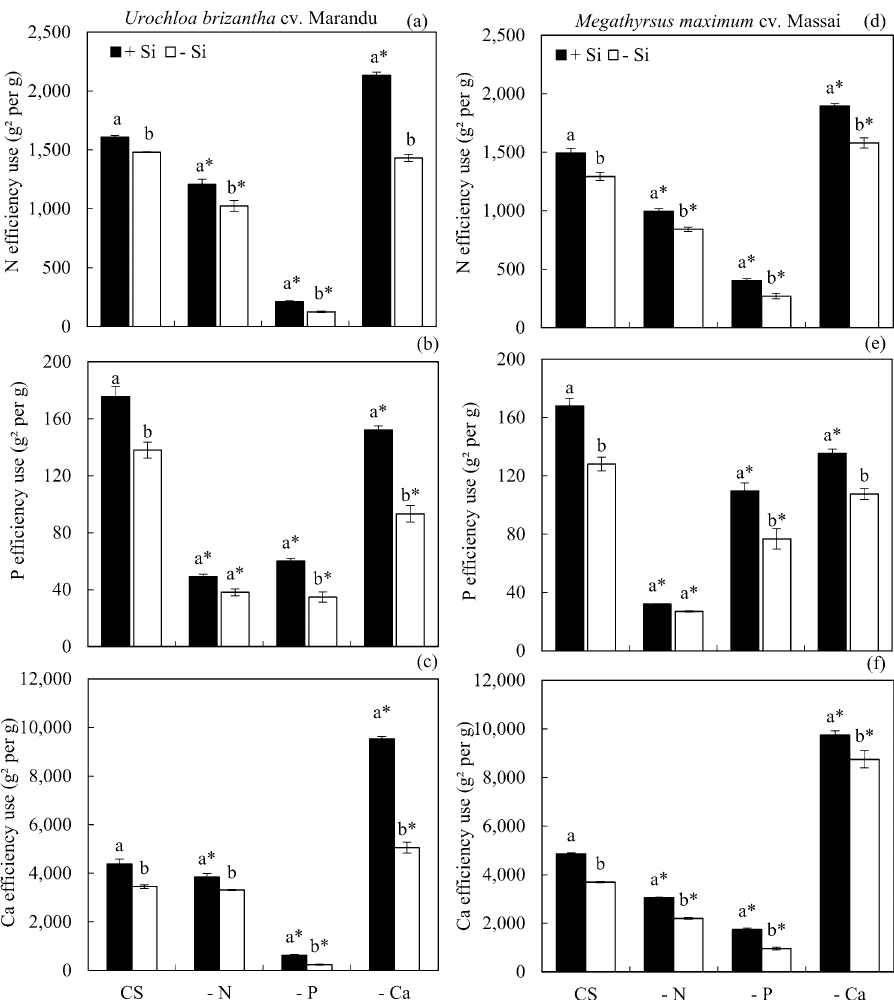
Figure 4. Efficiency of use the nitrogen (N) ( a , d ), phosphorus (P) ( b , e ) and calcium (Ca) ( c , f ) of Urochloa brizantha cv. Marandu and Megathyrsus maximum cv. Massai under grown in complete solution (CS) and deficiency of nitrogen (−N), phosphorus (−P) and calcium (−Ca), combined with Si (+Si) and without Si (−Si). Different letters indicate a significant difference between treatments in the +Si and −Si condition. *Indicates a significant difference between treatments with nutritional deficiencies in relation to treatments with CS, by the Tukey test ( p <